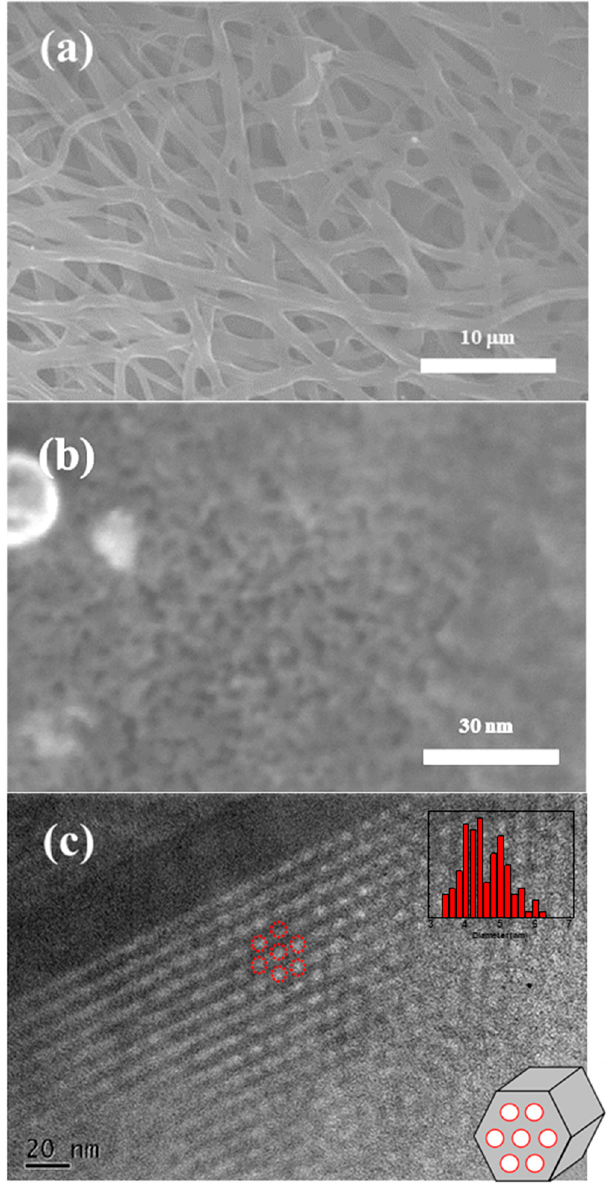
Figure 4. SEM images with low magnification ( a ) and high magnification ( b ), and a TEM image with pore size distribution ( c ) of MCF-A after 800 °C calcination. pore size distribution ( c ) of MCF-A after 800 ◦ C